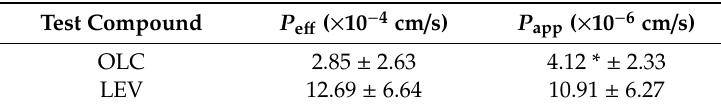
Table 2. Permeability coe ffi cients ( P e ff ) and apparent permeability coe ffi cients ( P app ) of oleocanthal and levofloxacin. Results are expressed as the mean ± SD of n = 4. Data are normalised to a 10-cm intestinal